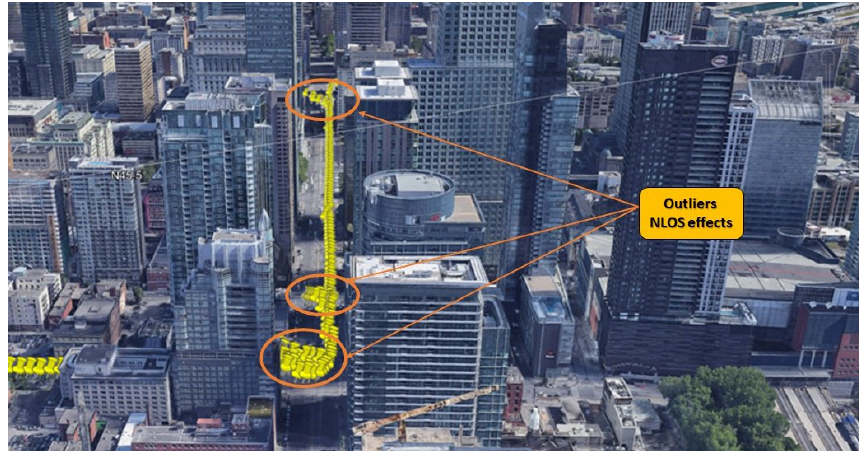
Figure 35. GNSS signals data collection in a Montreal urban environment with high buildings as obstacles.